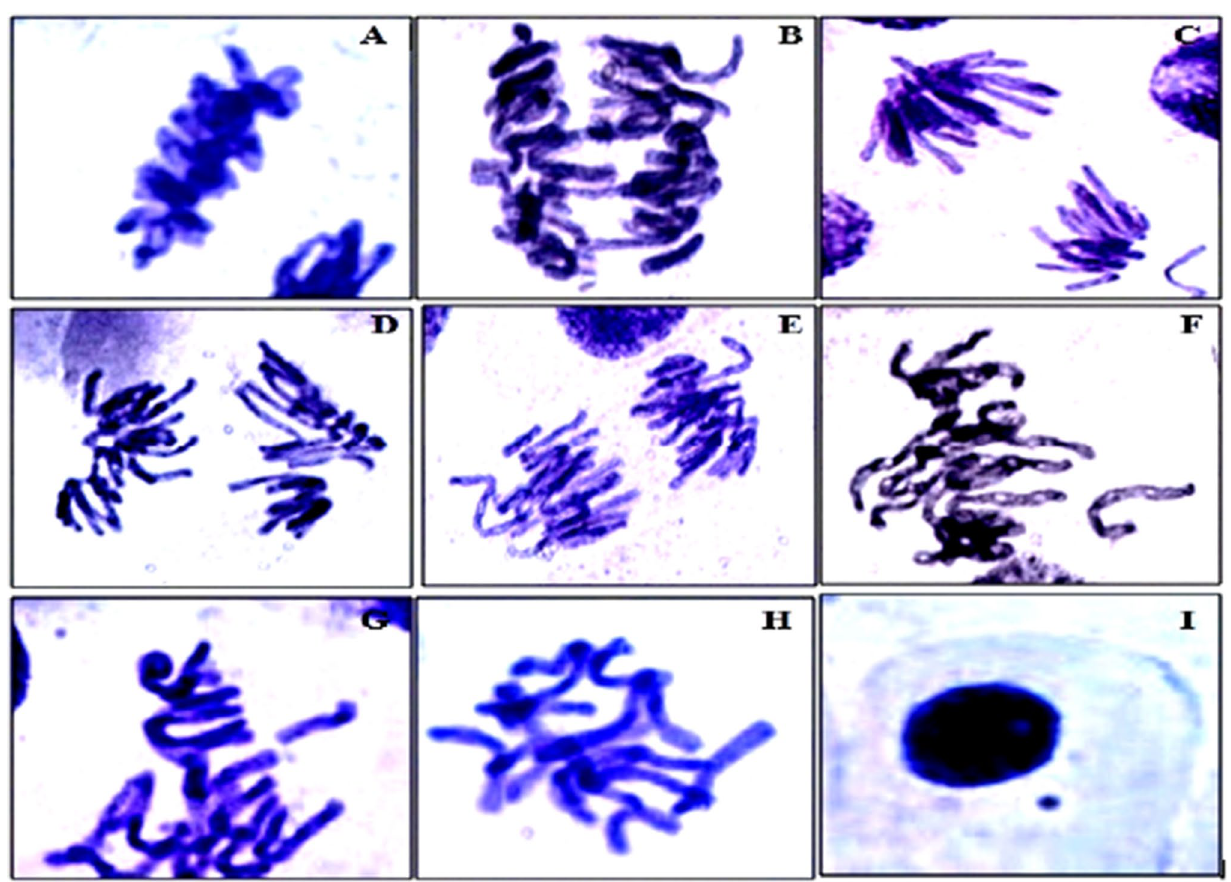
Fig. 4 Various stages of mitosis show chromosomal aberrations— stickiness ( a ), anaphase bridge ( b ), laggard ( c ), tripolar ( d ), vagrant ( e ), chromosomal loss ( f ), chromosomal break ( g ), c-mitosis ( h ), and